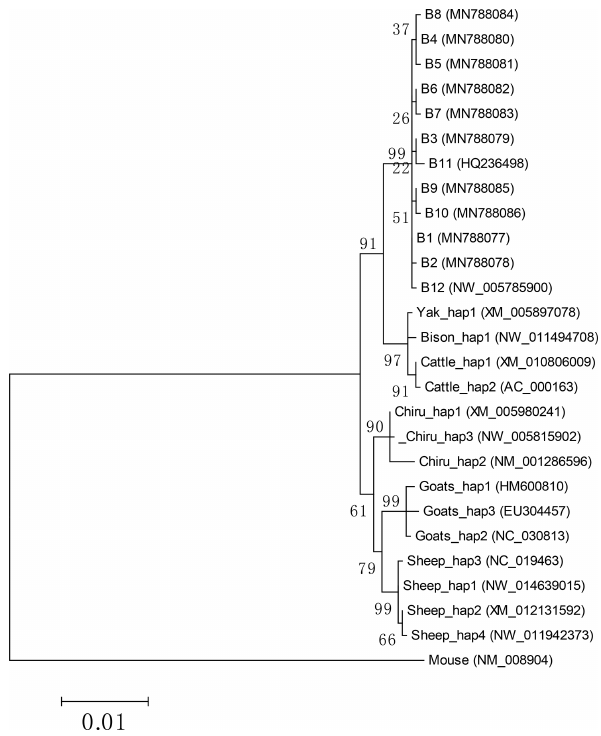
Figure 6. Differences of amino acid sequences corresponding to the haplotypes of PPARGC1A in the species of Bovidae. Table 5. Haplotype information on the buffalo PPARGC1A gene.